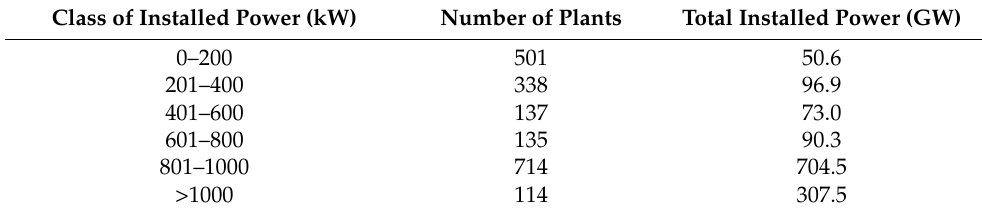
Table 2. Frequency of digesters categorized by their power capacities. Class of Installed Power